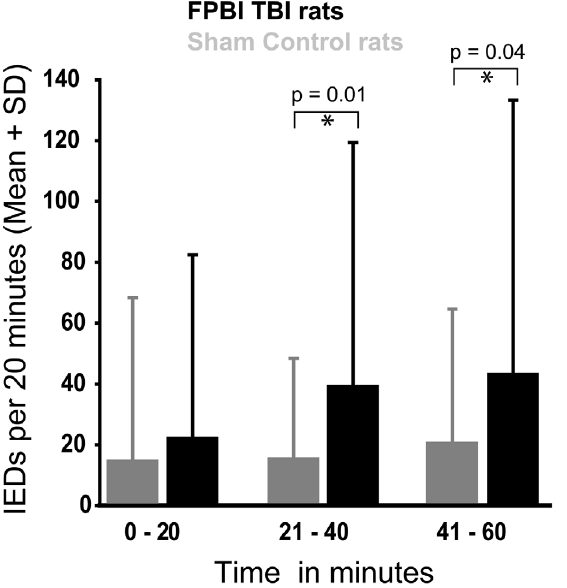
Figure 3. Evolution of interictal epileptiform discharges (IEDs) over time after administration of pentylenetetrazol (25 mg/kg body weight) in rats with lateral FPI (n=7) and sham-operated animals (n=6). Abbreviations: SD, standard deviation.